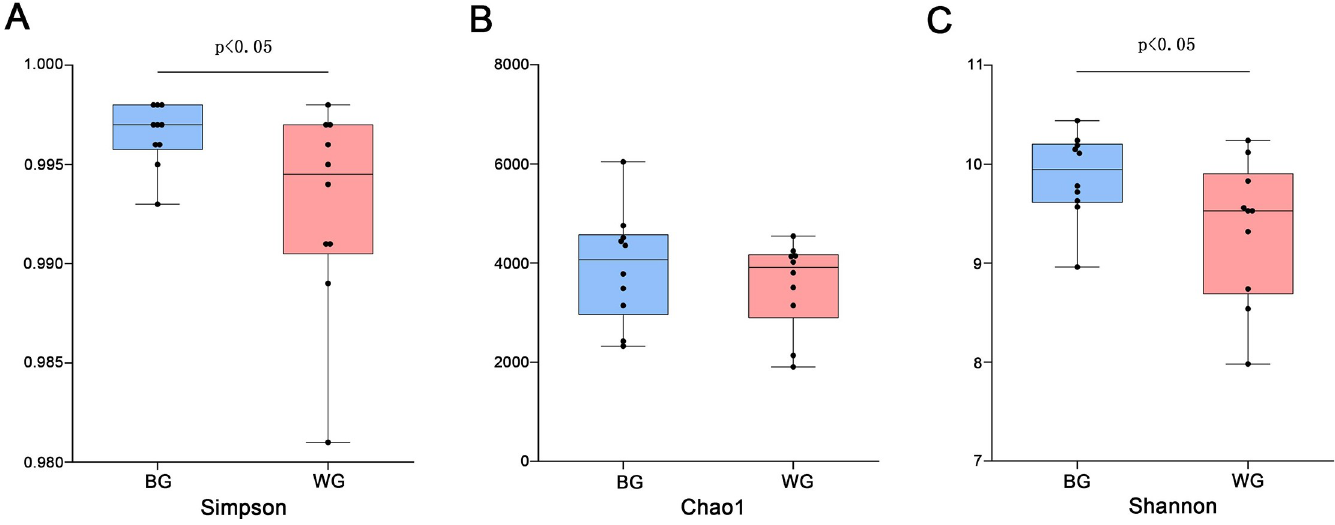
Fig 1. The alpha diversity between black goat (BG) and white goat (WG). P value was calculated using one-tailed unpaired t test.